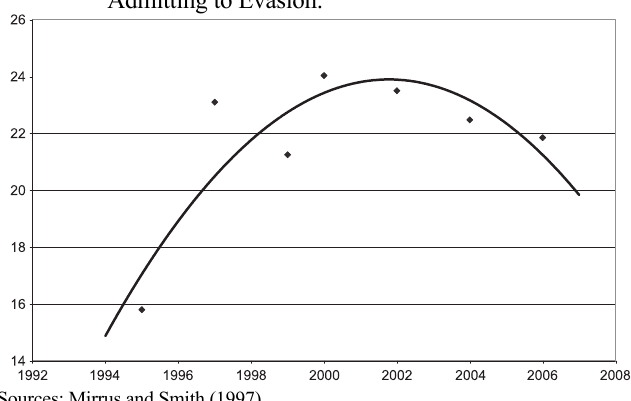
Figure 1 : Trends in Estimated Level of Tax Evasion (Quadratic Trend Added). Percentage of Those Surveyed Admitting to